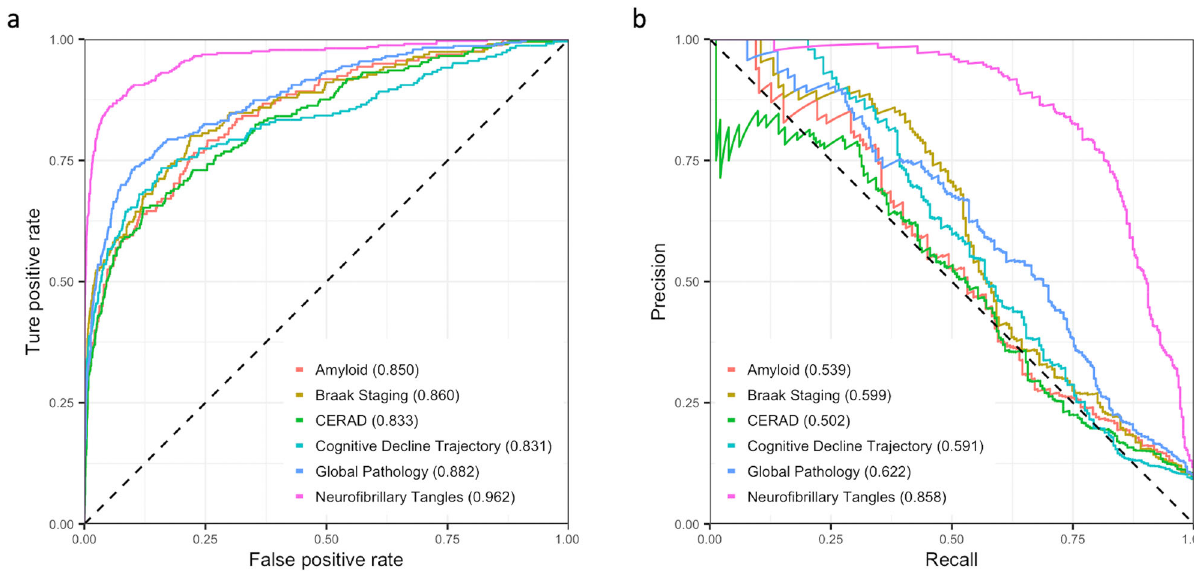
Fig. 2 Summary EWASplus results. a ROC curves of the predictive performance of EWASplus on the six traits in the ROS/MAP cohort. b Precision-recall curves of the predictive performance of EWASplus on the six traits in the ROS/MAP cohort. Source data are provided as a Source data fi